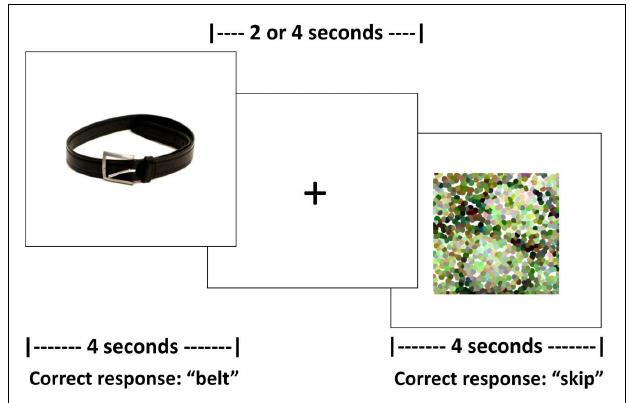
FIGURE 1 | Schematic of the fMRI picture naming